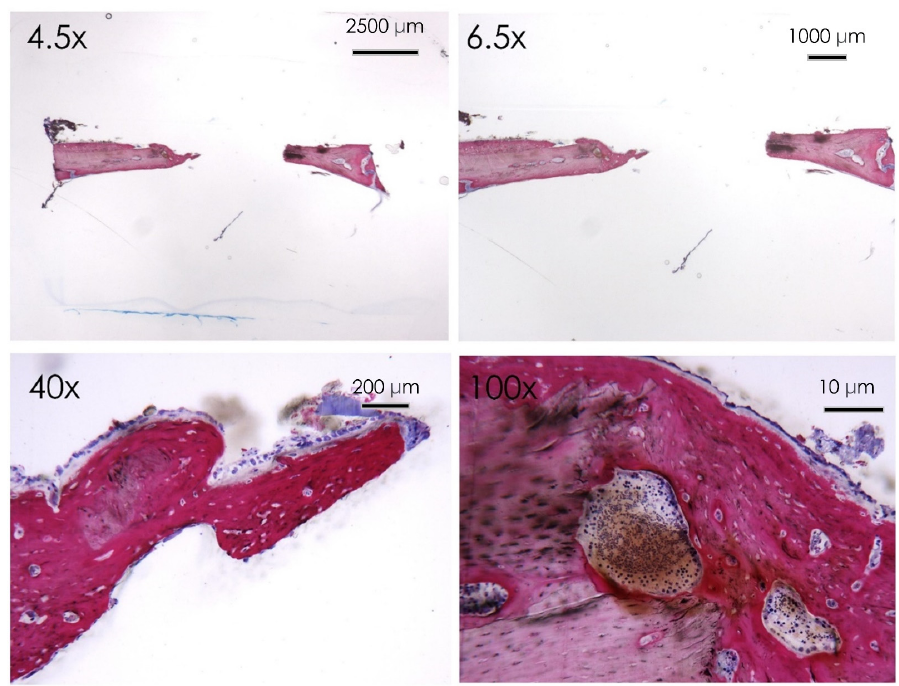
Figure 11. Curcumin group. Histological section of the calvaria bone specimens at different magnifications (4.5×, 6.5×, 40×, and 100×). A noncomplete filling of the bone defect was evident after 30 days of curcumin administration.